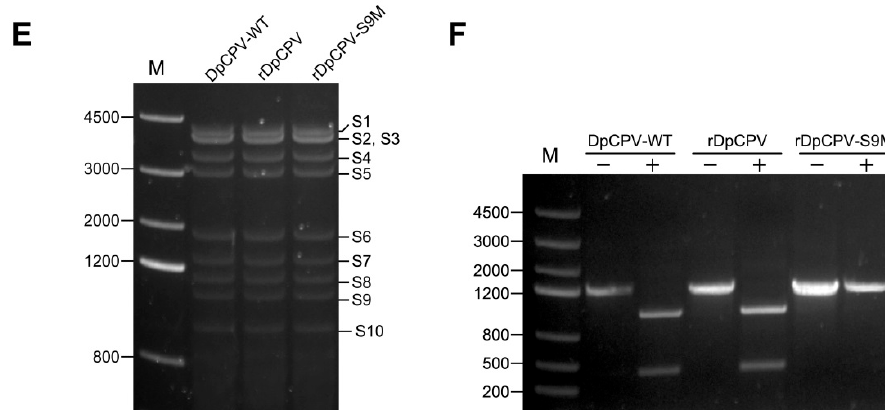
Figure 4. Generation and identification of the rescued DpCPVs. ( A ) OBs in Sf9 cells were obtained by transfection with the three DpCPV constructs shown in Figure 3 and AcBac-T7pol- ∆ vp80, and observed by optical microscopy. The Sf9 cells infected with DpCPV-WT were used as a control. Scale bars, 10 µ m. To compare the morphology of wild-type and rescued DpCPVs, the OBs were purified from midguts of S. exigua larvae and diluted to 1 × 10 6 OBs/mL and observed by optical microscopy ( B ), scanning electron microscopy ( C ) and electron microscopy ( D ). Scale bars, 1 µ m. There was no significant morphological differences between the wild-type and rescued DpCPVs. ( E ) Agarose gel electrophoresis of the genomes of DpCPV-WT, rDpCPV, and rDpCPV-S9M. M, molecular size marker. ( F ) Reverse transcription PCR products derived from the S9 genome segment of DpCPV-WT and recombinant rDpCPV, rDpCPV-S9M and rDpCPV-egfp were analyzed by agarose gel electrophoresis before and after digestion with Hin dIII. − , undigested RT-PCR product; +, Hin dIII-digested RT-PCR